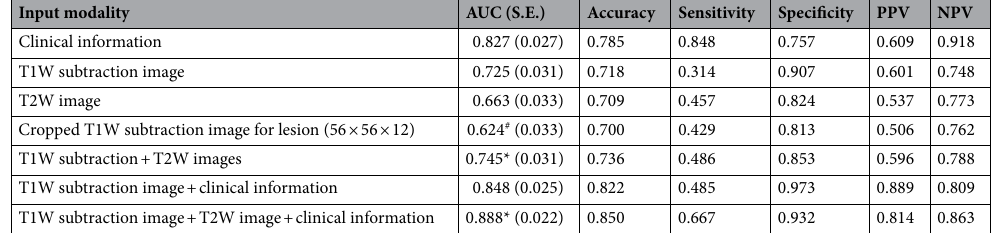
Table 2. Performance of seven deep learning models in a validation dataset in predicting pCR. * Statistically significant difference ( p < 0.05) compared to Clinical information. # Statistically significant difference ( P < 0.05) compared to T1W subtraction image.